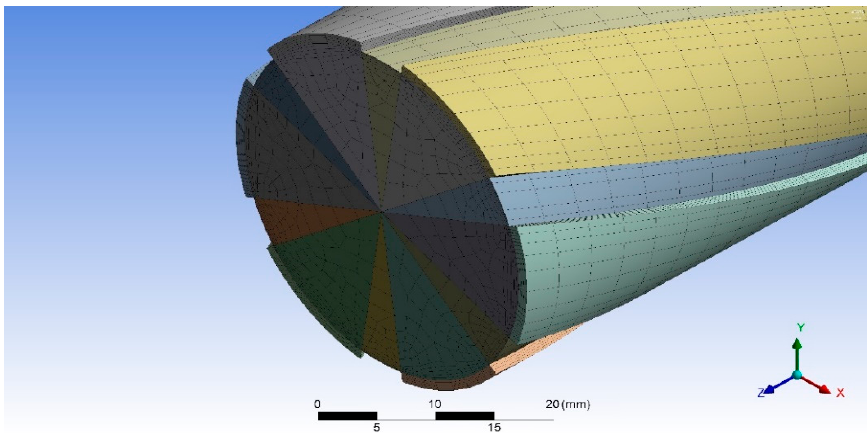
Figure 11. Fragment of the fluid model used to determine linear frictional losses.